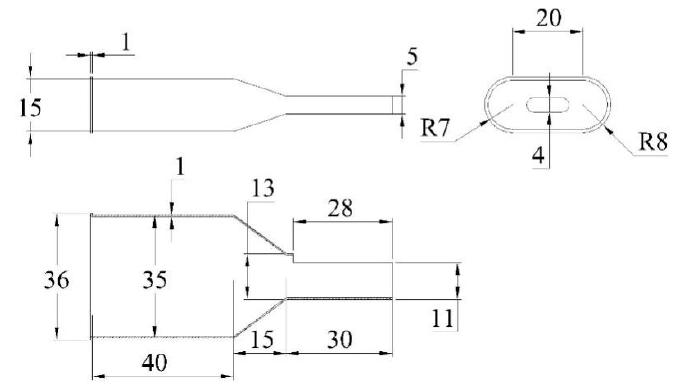
Figure 12. Orthographic views of the venturi (unit: mm).